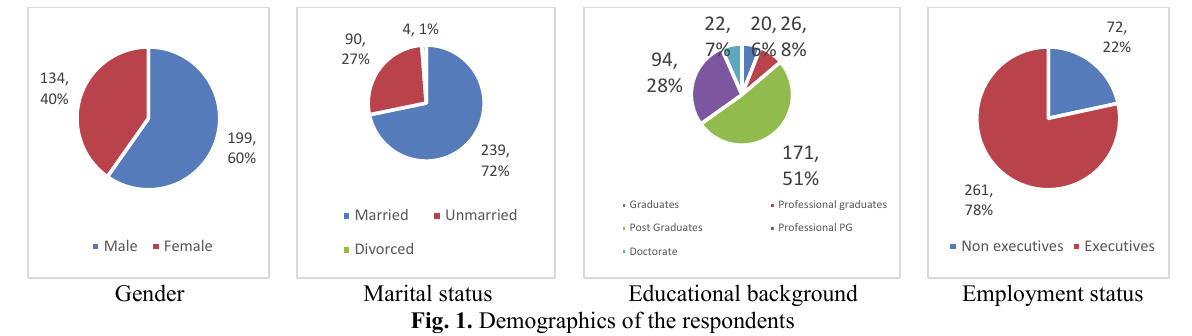
Fig. 1. Demographics of the